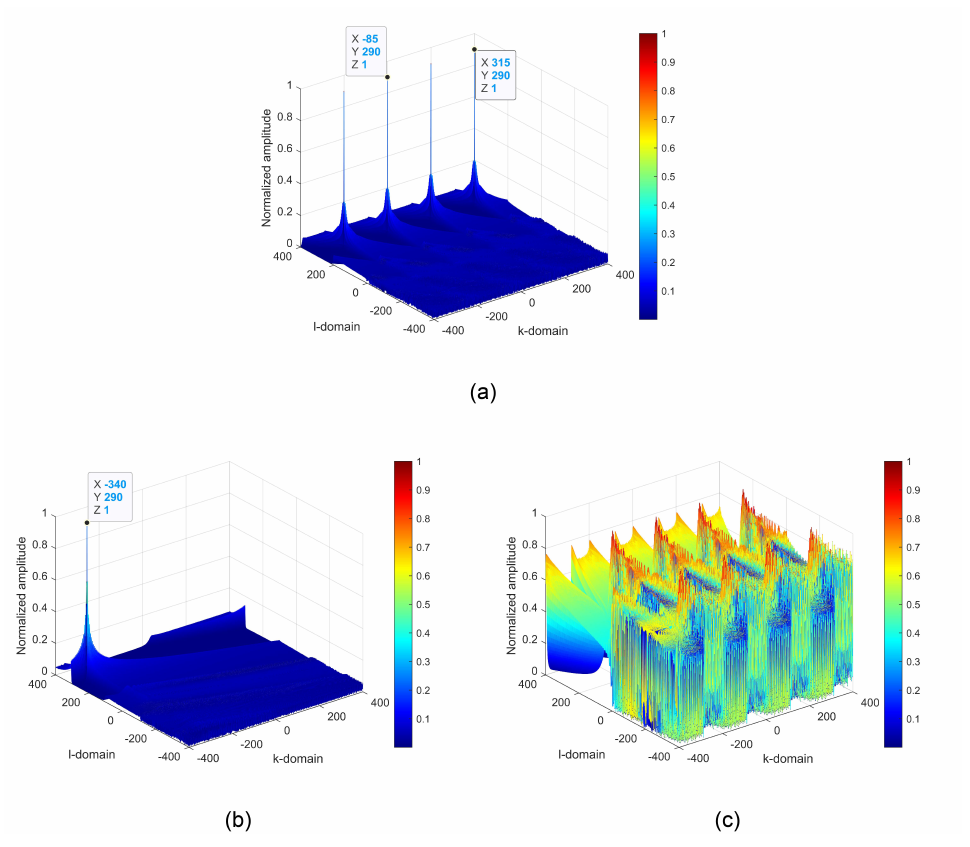
Figure 2. Simulation results of Example 2. ( a ) The correct result of ZDCFT ( α = 4, β = 2). ( b ) The blurred result of ZDCFT ( α = 1, β = 2). ( c ) The invalid result of ZDCFT ( α = 4, β =